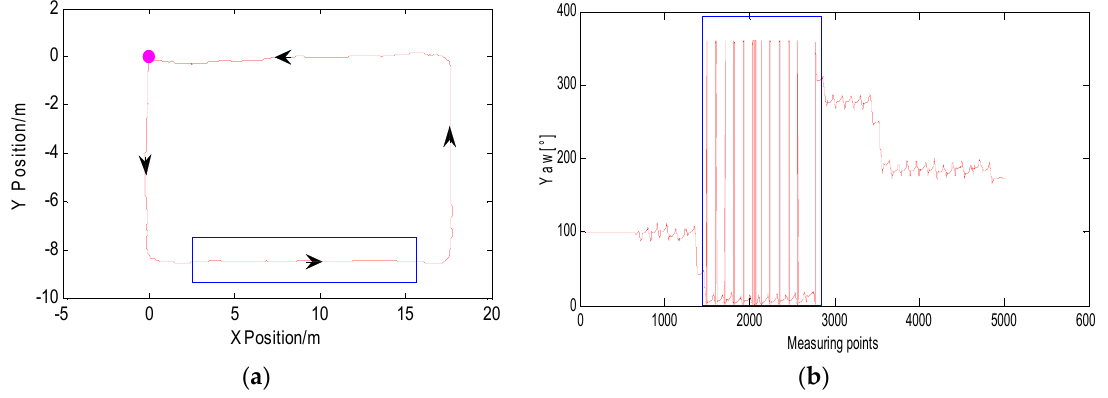
Figure 3. ( a ) Pedestrian trajectory of inertial navigation system (INS) output and ( b ) corresponding heading angle data during walking.